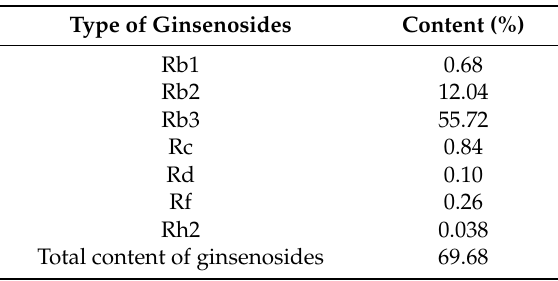
Table 2. Composition of Panax ginseng leaf extract (PGLE) used in this study.